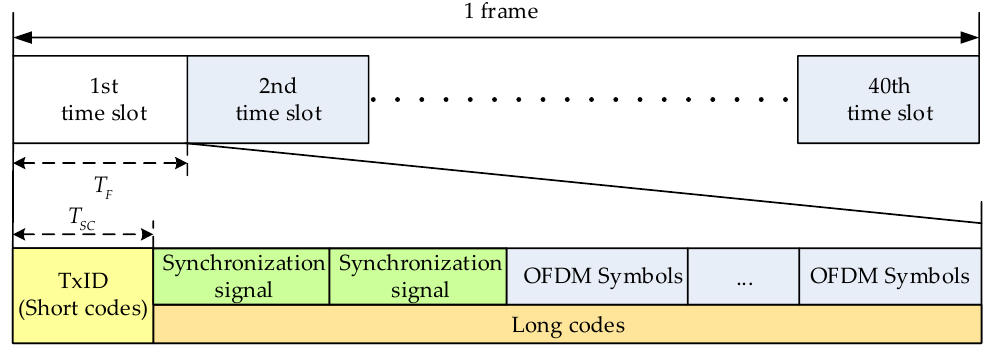
Figure 3. Structure of the fusion signal.